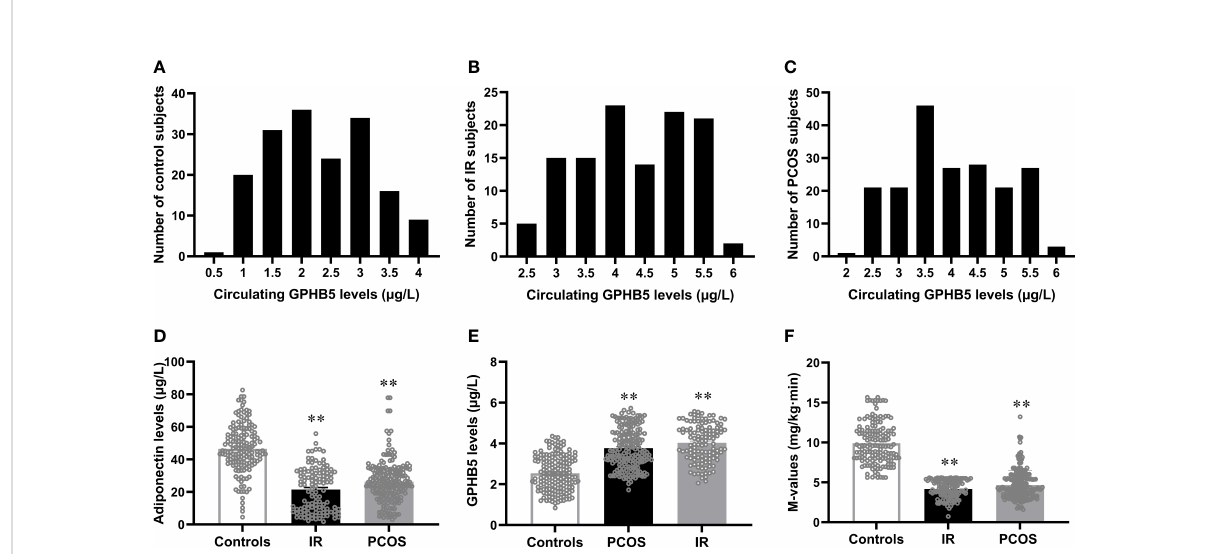
FIGURE 5 Circulating GPHB5 and adiponectin levels and M-values in the study population. (A-C) Distribution range of circulating GPHB5 concentration in the controls (A) , IR (B) and PCOS (C) individuals. (D) Circulating adiponectin levels in three groups. (E) Circulating GPHB5 levels in three groups. (F) M-values during the EHC. Data are means ± SD. ** p < 0.01 vs. controls.